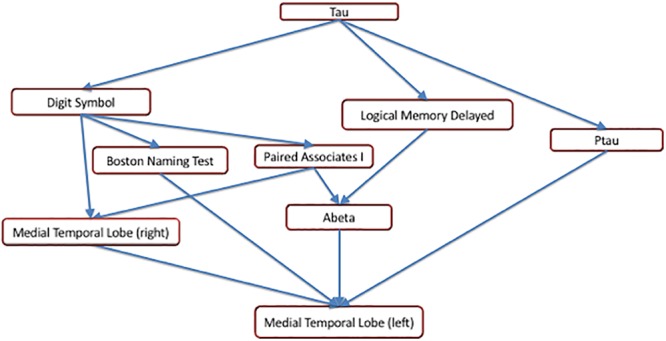
A precedence graph representing the order of the changepoints among the variables with significant changepoints. An arrow between groups of variables indicates that, more than 75% of the time, the changepoint for the variable represented as the ‘source’ was found to be earlier than the changepoint for the variable represented as the ‘target,’ using bootstrap samples. The groupings of the variables were computed using hierarchical clustering within each modality, based on the precedence probability vectors. Arrows that can be inferred by transitivity are not shown for clarity.